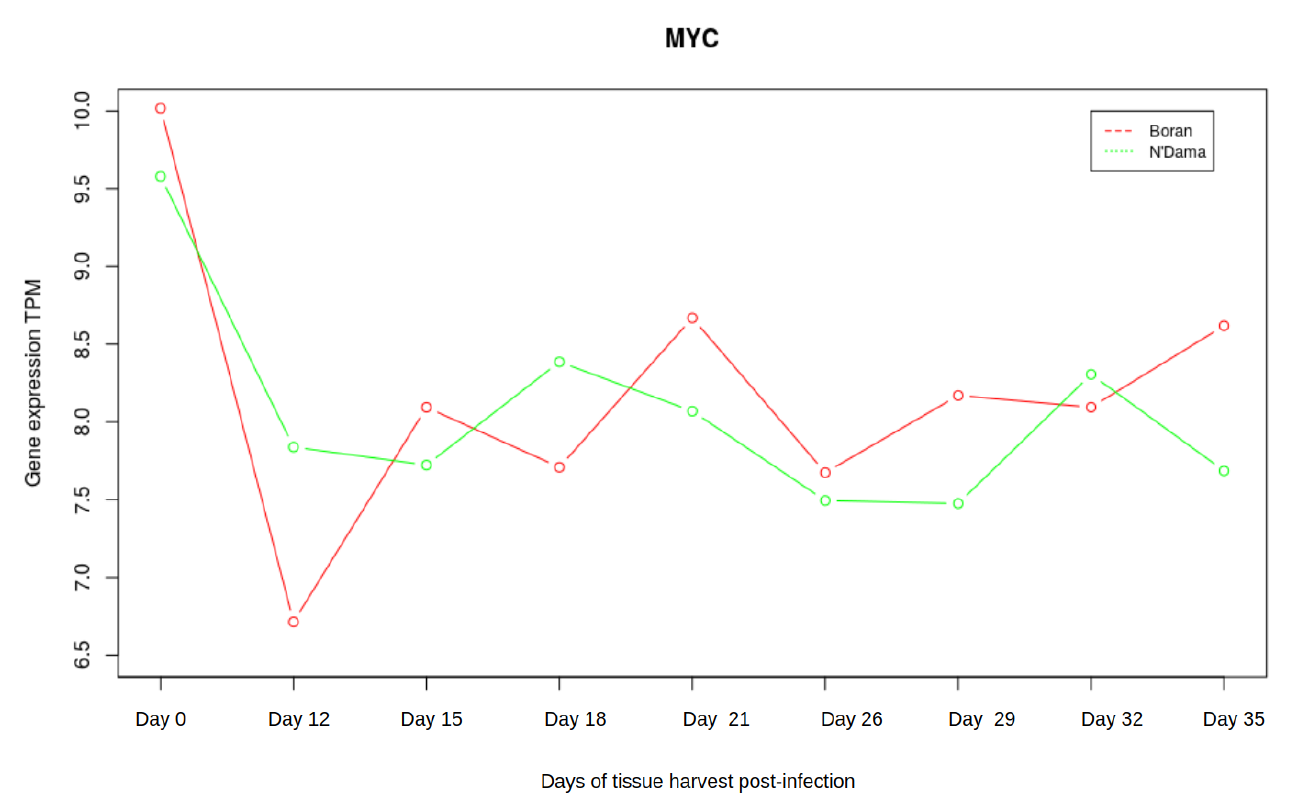
Figure 7. Expression of MYC .The red line in the plot corresponds to Boran whereas the green line corresponds to the breed N’Dama. In the early timepoints, expression of MYC decreases in both Boran and N’Dama. At the later stage, the expression of MYC increases for Boran whereas it decreases for